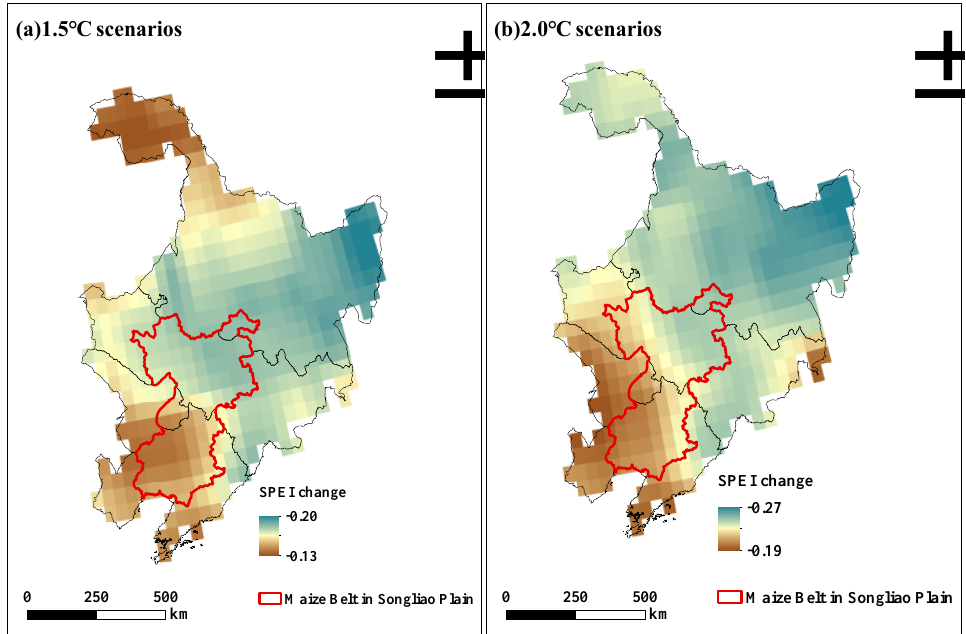
Figure 9. Spatial variation in the SPEI-3 in the Songliao Plain maize belt relative to 1986–2005 under the 1.5 °C ( a ) and the 2.0 °C ( b ) global warming scenarios.